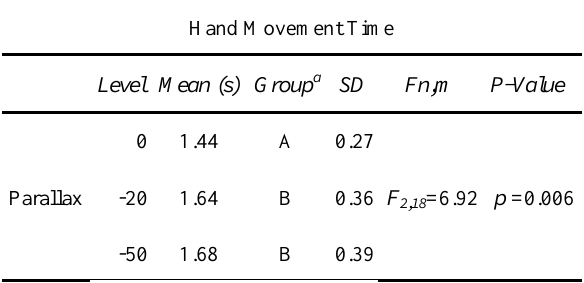
Means, SDs, ANOVA, and Tukey HSD test results of hand movement time Hand Movement Time